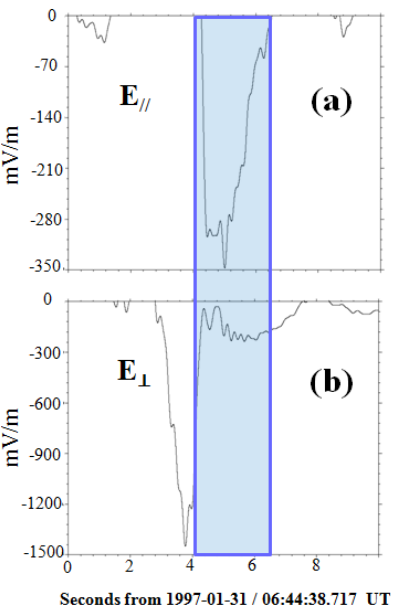
Figure 3. Parallel (a) and perpendicular (b) components of the DC electric field measured at the same time as the electron and ion en- ergy fluxes. The large unipolar negative excursion of the parallel electric field (blue shaded region) indicates the presence of a field aligned potential difference.